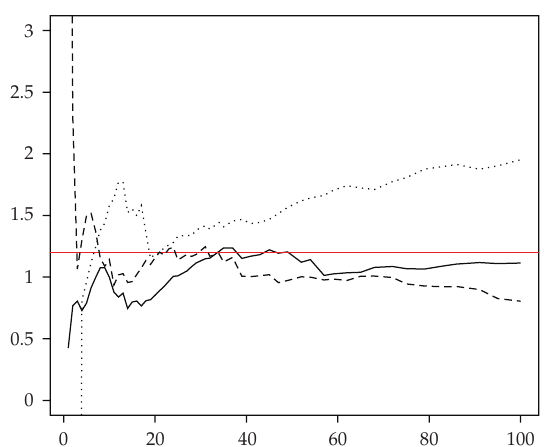
Figure 1: Plots of Hill estimators, as functions of the number of extreme statistics, (cid:5) α (cid:2) solid line (cid:3) , (cid:5) α R (cid:2) dashed line (cid:3) , and (cid:5) α L (cid:2) dotted line (cid:3) of the characteristic exponent α of a stable distribution skewed to the right, based on 1000 observations with 50 replications. The horizontal line represents the true value of α (cid:4) 1 . 2.